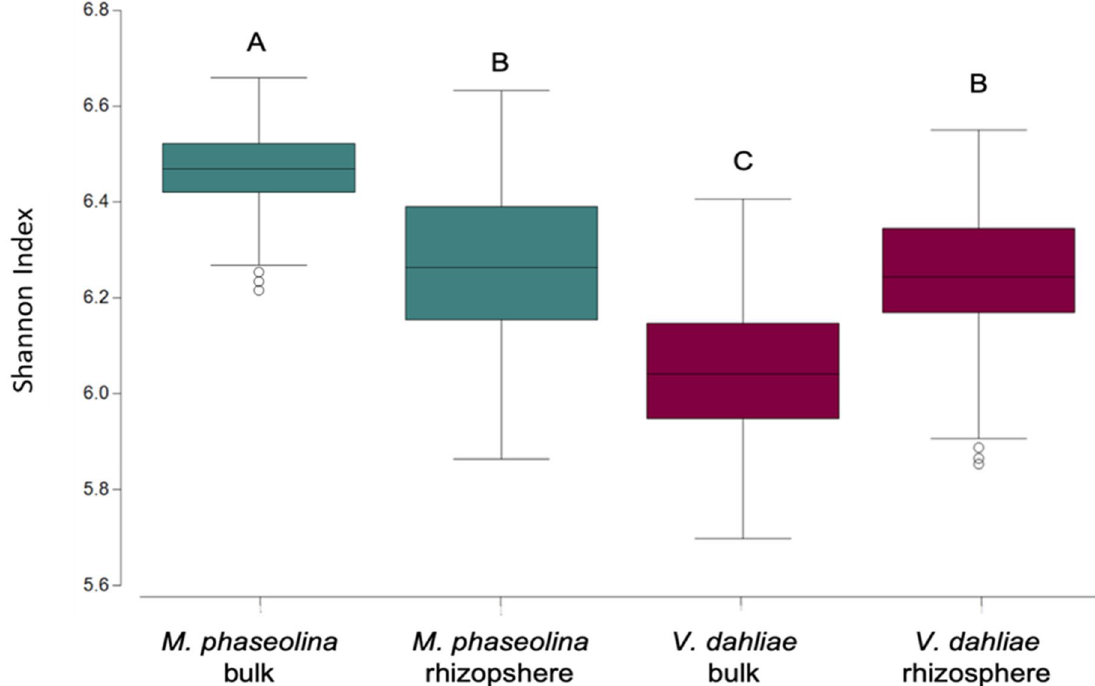
Figure 3. Diversity of the microbial community in the bulk and rhizosphere soil from the pathogen trials inoculated with Macrophomina phaseolina and infested with Verticillium dahliae . Different letters denote significant differences at p < 0.005.